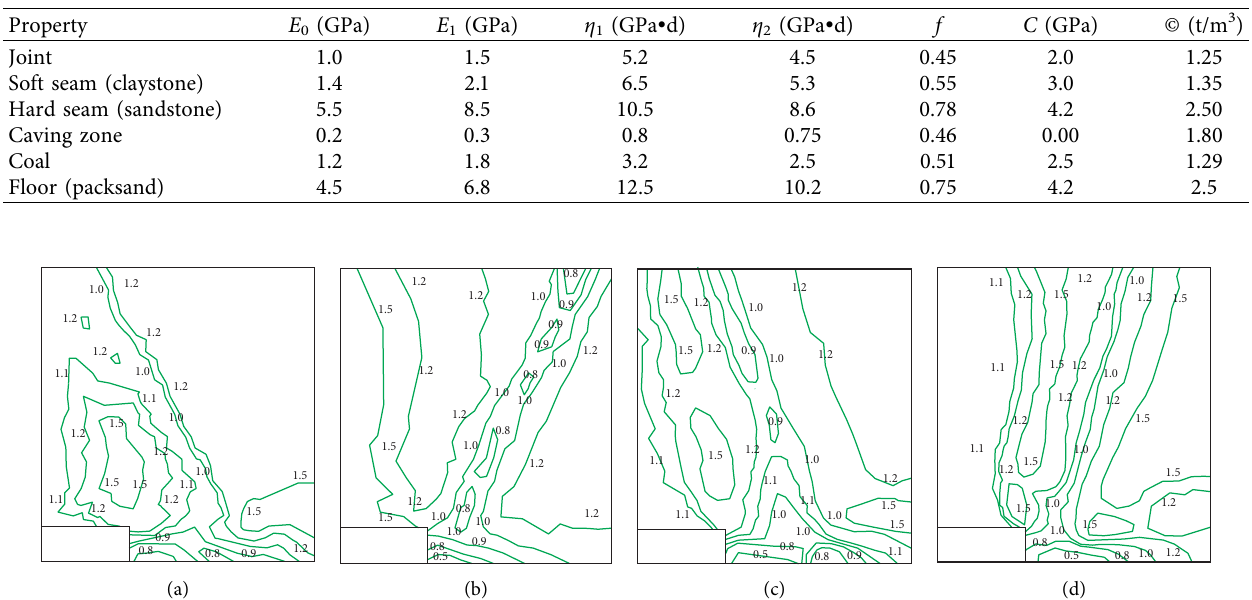
Figure 8: Point safety factor of different overburden structures. (a) Hard-Soft. (b) Soft-Hard. (c) Soft-Soft. (d)